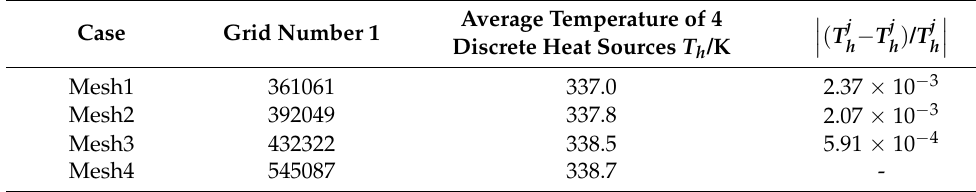
Table 3. Grid independence verification.